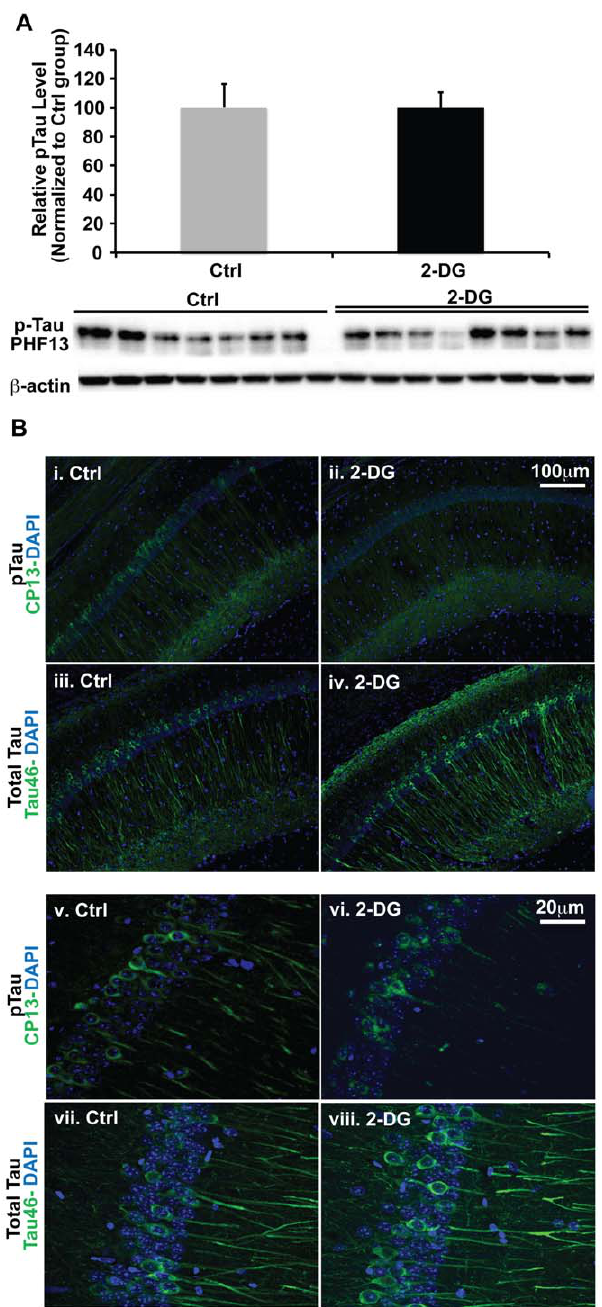
Figure 5. 2-DG did not regulate Tau hyperphosphorylation. Hippocampal homogenate samples from both the Ctrl and 2-DG groups were analyzed for protein levels of pTau (PHF13) by western blot. Brain sections were stained for pTau (CP13) and total Tau (Tau 46). A, 2-DG did not affect pTau protein level; B, immunofluorescent labeling of pTau (CP13) and total Tau (Tau 46) in the hippocampal CA1 region. Images i–iv: lower magnification, Scale bar: 100 m m; images v–viii, higher magnification, scale bar: 20 m m. Images i, ii, v, and vi: pTau (CP13) + DAPI; images iii, iv, vii, and viii: total Tau (Tau46) + DAPI. doi:10.1371/journal.pone.0021788.g005 (Arc), a common marker for synaptic activity, in the hippocampus. 2-DG induced a significant increase in expression of BDNF homodimers and NGF (Fig. 6A, P , 0.05). While total Arc protein